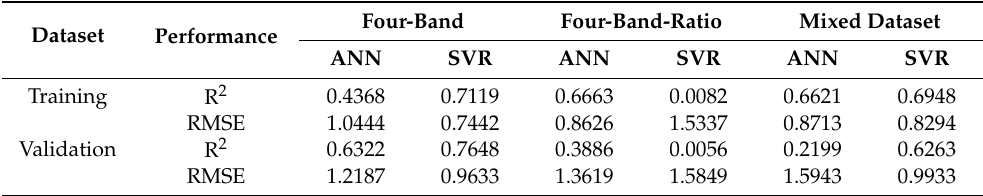
Table 5. Model performance of the ANN and SVR